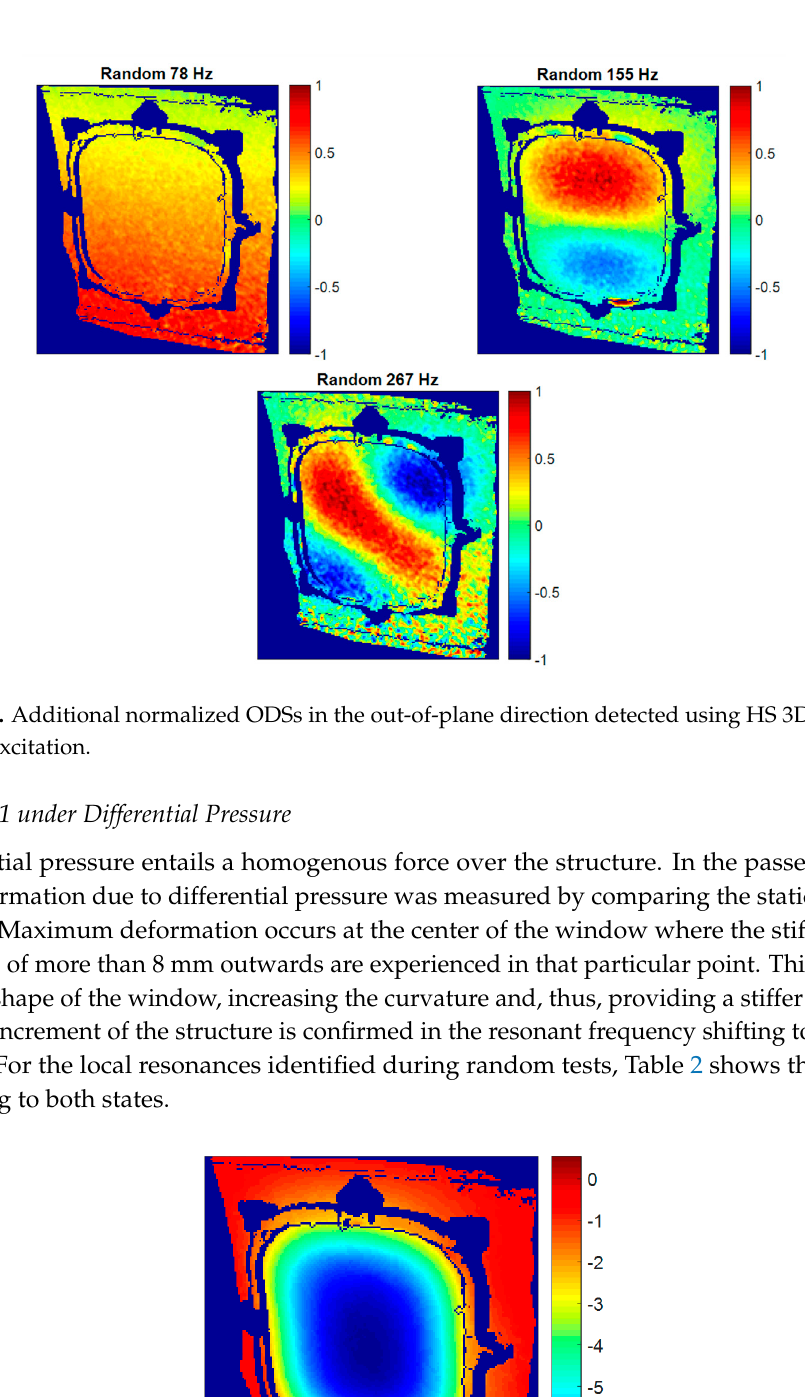
Figure 13. Normalized operational deflection shapes in the out-of-plane direction obtained using HS 3D-DIC under different excitation configurations.